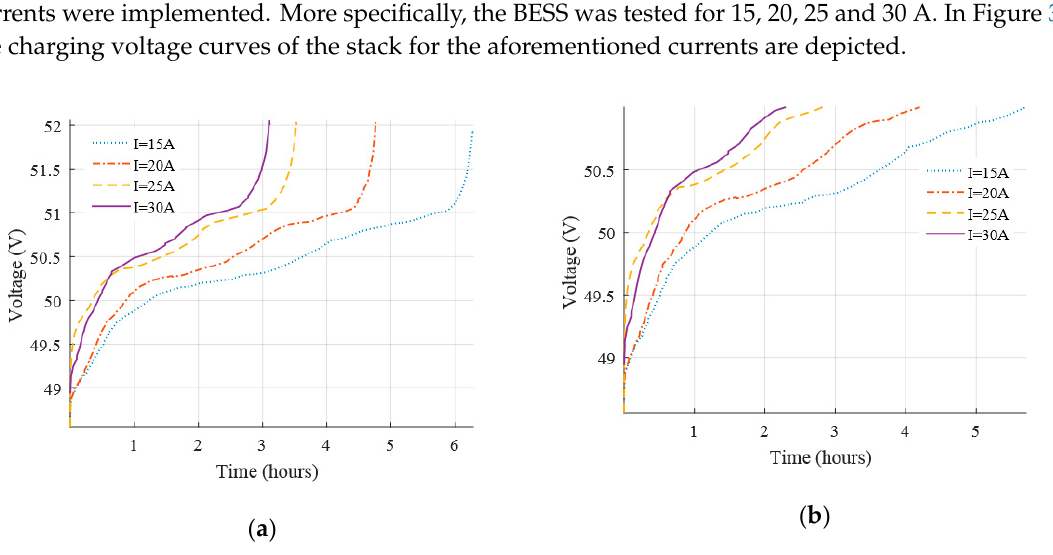
Figure 3. Charging voltage curves: ( a ) Whole charging curves; ( b ) Trimmed charging curves.